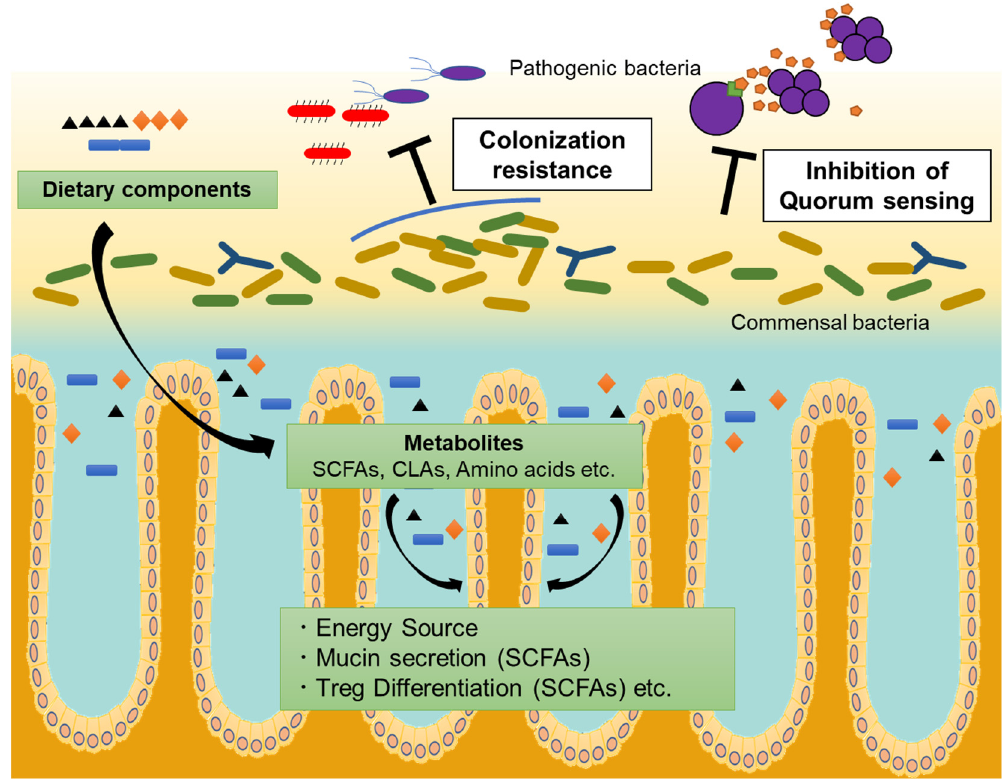
Figure 1. Role of the gut microbiota in dietary metabolism and defense from pathogens. The commensal microbiome shows mucosal protective effects through dietary metabolism and colonization resistance. In addition, the commensal microbiome inhibits quorum sensing, which has a protective effect on the gut mucosa.